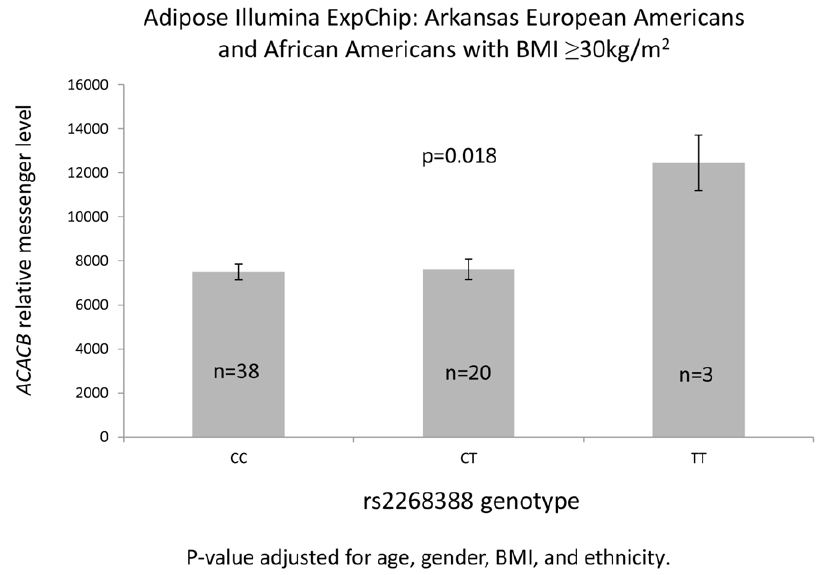
Figure 3. Adipose ACACB expression by rs2268388. doi:10.1371/journal.pone.0056193.g003 PLOS ONE |